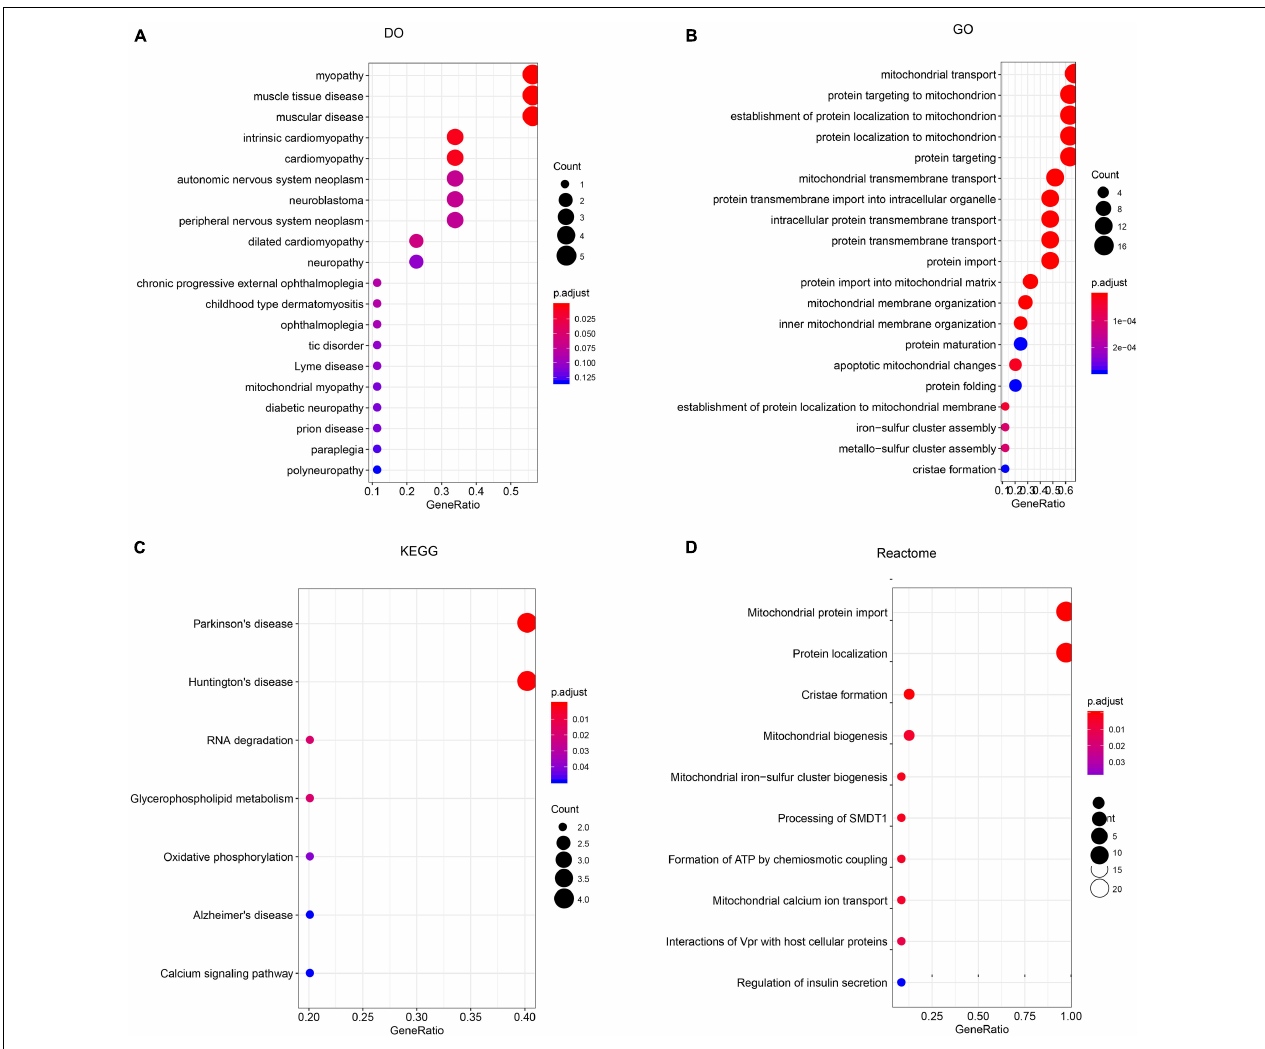
FIGURE 5 | Enrichment analysis of TIMM17A neighbor genes altered in breast carcinoma. The bubble diagrams display the enrichment results of the top 50 TIMM17A neighbor genes altered in BRCA. (A) Disease Ontology (DO). (B) Gene ontology (GO). (C) Kyoto Encyclopedia of Genes and Genomes (KEGG). (D) Reactome analysis.